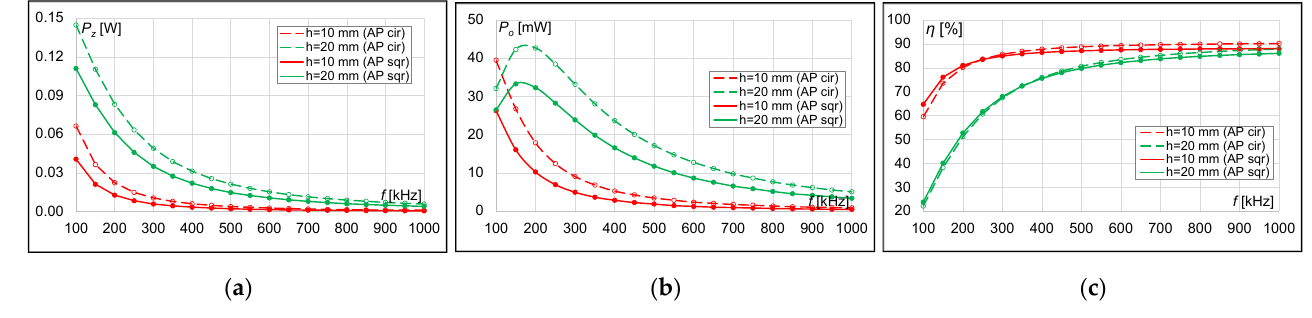
Figure 28. Results for the aperiodic system with circular or square coils with r = 20 mm and the number of turns n = 50 at two distances ( h = 10 mm and h = 20 mm): ( a ) transmitter power, ( b ) receiver power, ( c ) power transfer efficiency.